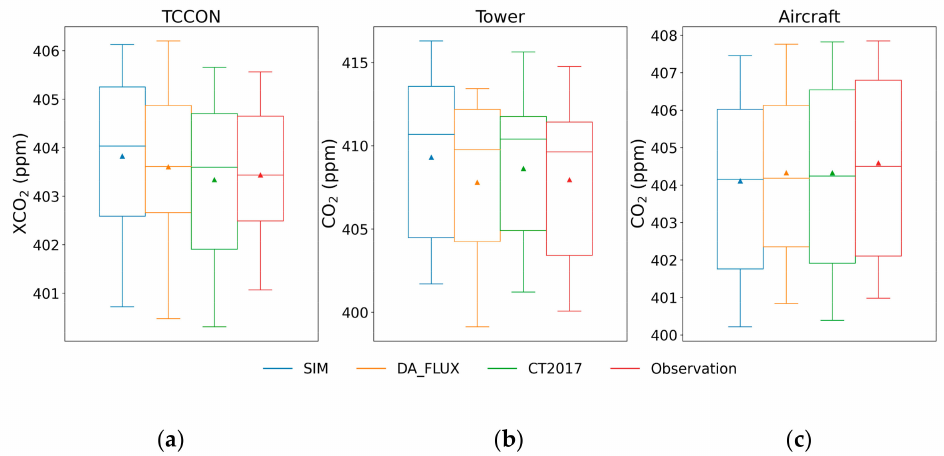
Figure 11. Boxplots of the different types of monthly mean observations, ( a ) for TCCON observations, ( b ) for tower observations, ( c ) for aircraft observations, and the corresponding monthly mean XCO 2 or CO 2 concentrations from SIM, DA_FLUX and CT2017. The lower and upper edges of the boxes represent the first (Q1) and third (Q3) quartiles, the lower and upper whiskers represent the minimum and maximum values within 1.5 times the interquartile range from Q1 and Q3, respectively, solid lines and triangles represent median and mean value. Table 6. Evaluation results between the monthly mean CO 2 concentration or XCO 2 observations and the corresponding results from SIM, DA_FLUX and CT2017, where the CORRs are statistically significant at the level of p < 0.01. Observation